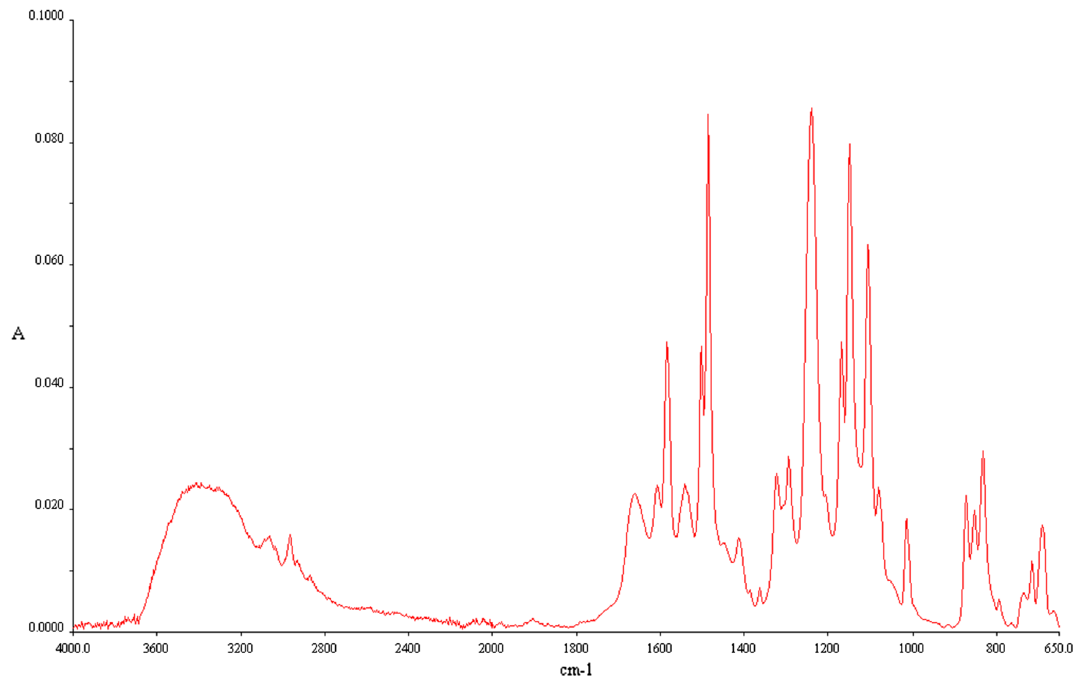
Fig. 3 FTIR spectra of the virgin Hydranautics membrane